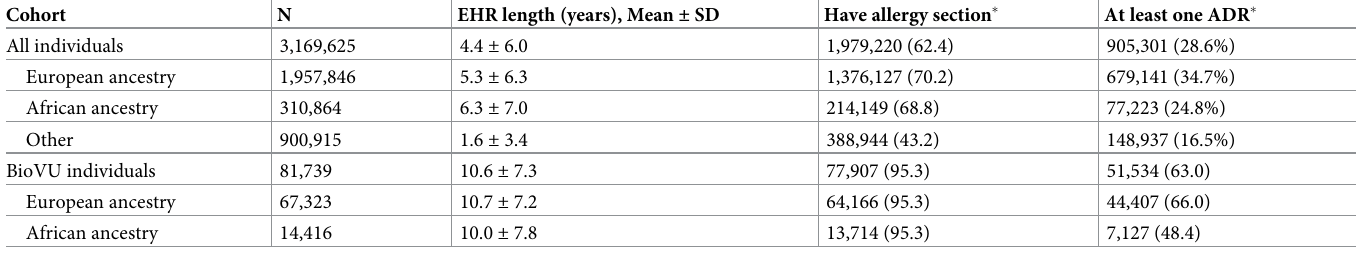
Table 1. Summary of selected EHR characteristics for all VUMC individuals and the BioVU individuals selected for genetic analyses, stratified by self-reported ancestry. Cohort N EHR length (years), Mean ± SD Have allergy section � At least one ADR � All individuals African